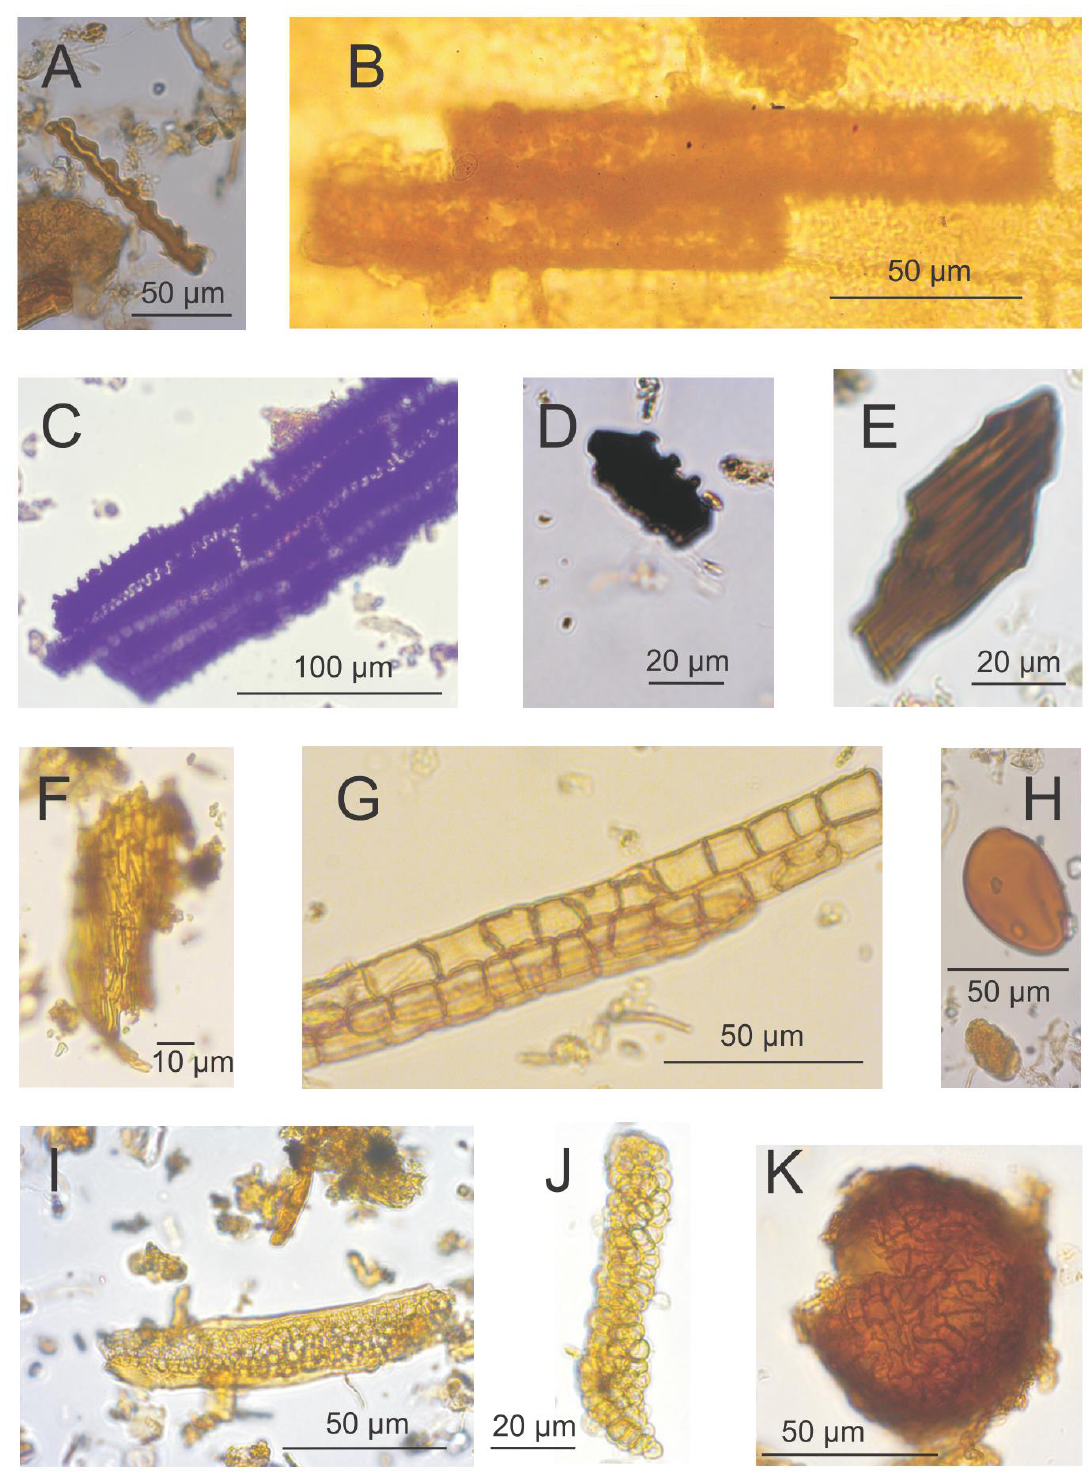
Figure 2. Microscopic remains: ( A ) EMA-62A Cell infills with undulating edges, ( B ) EMA-62A inside leaf sheath (from macroscopic sample), ( C ) EMA-132 charred: charred cell complex of Cyperaceae epidermis, ( D ) separate cells of EMA-132 charred, ( E )‒( F ): EMA-162: moss leaf fragment with prosenchymatic cell pattern, charred ( E ) and not charred ( F ). ( G ), ( I ), ( J ) EMA-85: Fungal plectenchyma in shape of vascular plant cell, ( H ) EMA-160 Fungal spore, ( K ) EMA-161 Fungal fruit body.